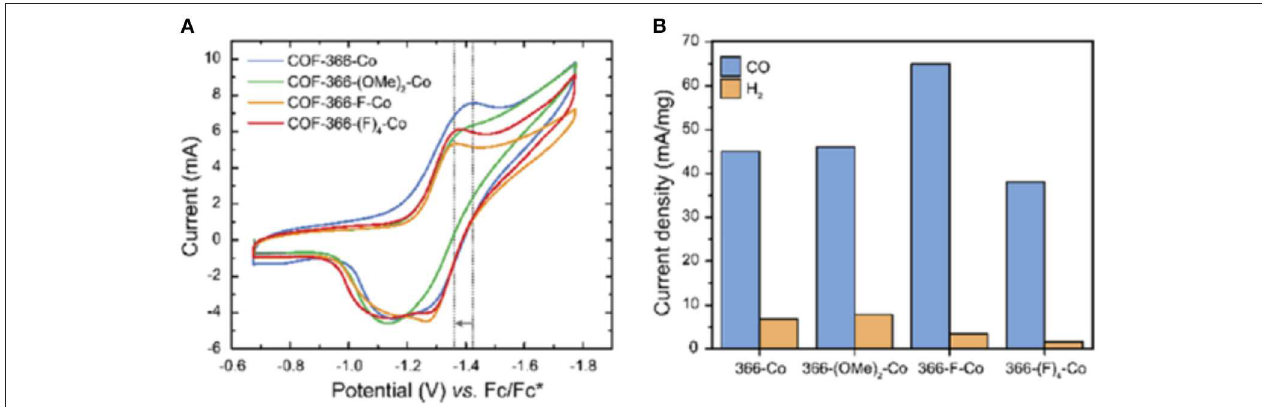
FIGURE 16 | (A) Cyclic voltammograms of four COFs synthesized by Diercks et al. (2018a) in N,N-dimethylformamide. Tetrabutylammonium hexafluorophosphate was used as the electrolyte and (B) the current densities of four COFs synthesized by Diercks et al. (2018a) reported per milligram of cobalt. Measurements were reported by Diercks et al. (2018a) in a 0.5M aqueous potassium bicarbonate buffer under an applied potential of − 0.67V vs. Reprinted with permission © 2018 The American Chemical Society.